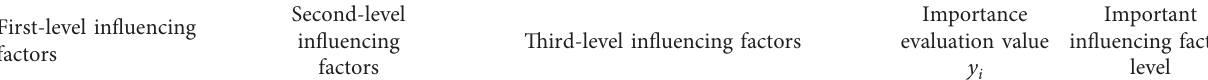
Table 1: Evaluation value of alternative influencing factors of technological independent innovation in equipment manufacturing